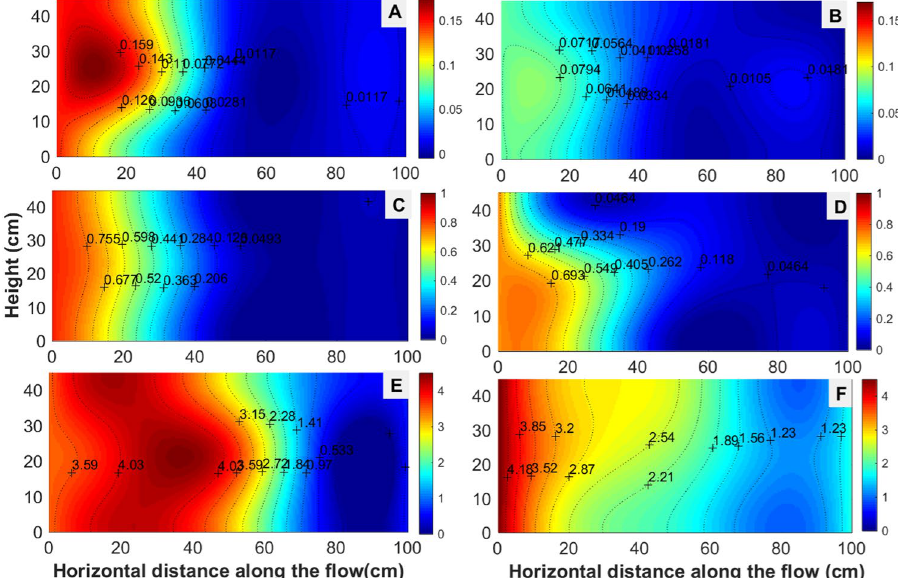
Figure 2. Longitudinal isopleth maps of the TAP concentrations in the horizontal flow constructed wetland (HSCW) loaded with influent TAP concentrations of 0.12 ± 0.04 mg L − 1 ( A and B ), 0.79 ± 0.29 mg L − 1 ( C and D ) and 3.96 ± 1.17 mg L − 1 ( E and F ) at the hydrological loading (HLR) of 100 mm d − 1 ( A , C and E ) and 200 mm d − 1 ( B , D and F ). The legend bar on the right side of each plot was scaled with the range of the TAP concentration.